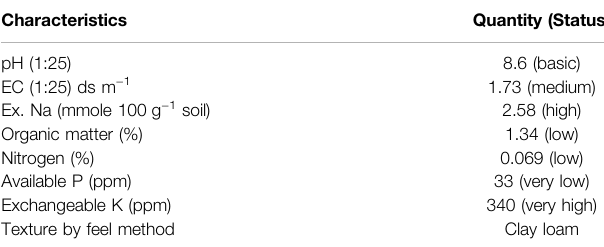
TABLE 2 | Physico-chemical characteristics of the experimental soil.